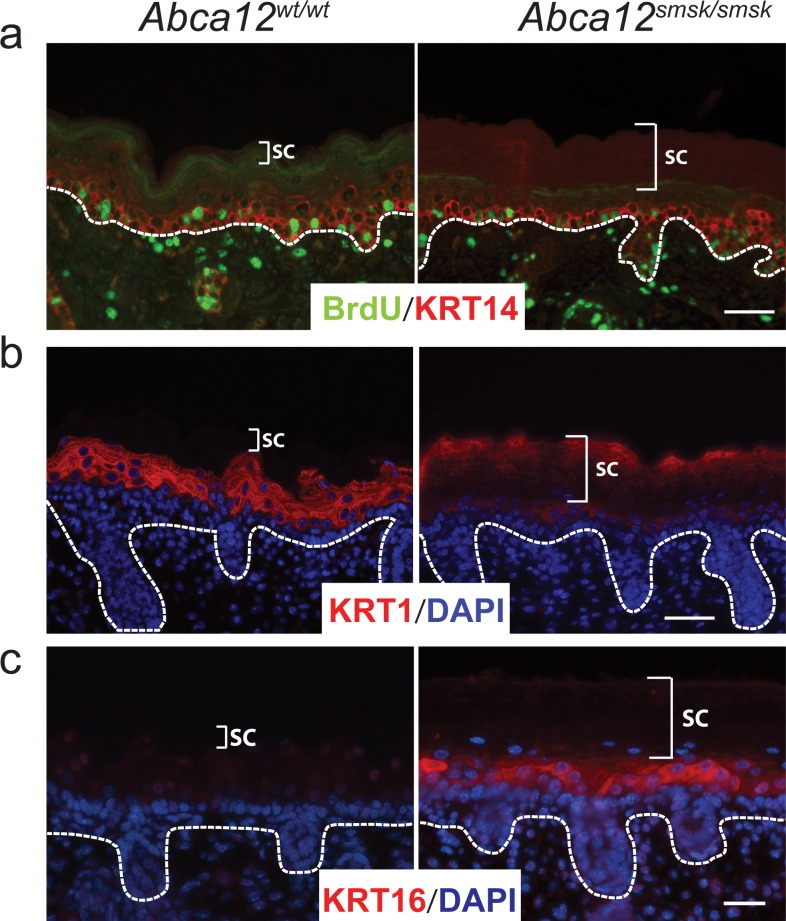
Abca12smsk/smsk displays defects in terminal differentiation.(a). Cell proliferation rates were similar in both WT and smsk embryonic epidermis as determined by in utero incorporation of 5-bromo-2'-deoxyuridine (BrdU). Sections were stained with an anti-BrdU antibody (green) and counterstained with KERATIN 14 (KRT14) (red). Note that no difference in the expression pattern of KRT14 was observed in either WT or mutant epidermis. Bars = 25 μm. (b) Keratinocytes in Abca12smsk/smsk mutant skin undergo abnormal terminal differentiation as demonstrated by scattered pattern of KRT1 (red) detection in the SC. Bars = 50 μm. (c) KRT16 (red) was ectopically expressed in the interfollicular suprabasal keratinocytes of Abca12smsk/smsk epidermis, whereas it was undetecteable in the WT epidermis. Furthermore, the retention of nuclei (parakeratosis) in the SC is observable in smsk mutant skin. Bar = 25 μm.